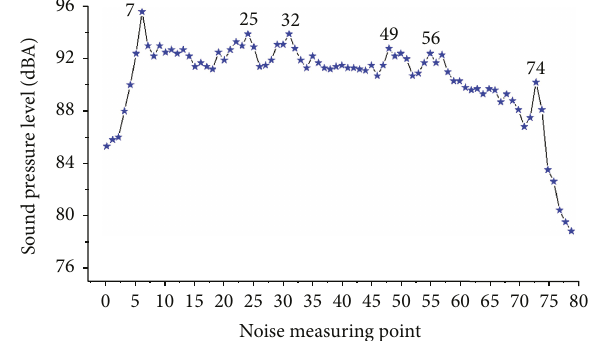
Figure 12: Aerodynamic noise level of high-speed railways on bridges.